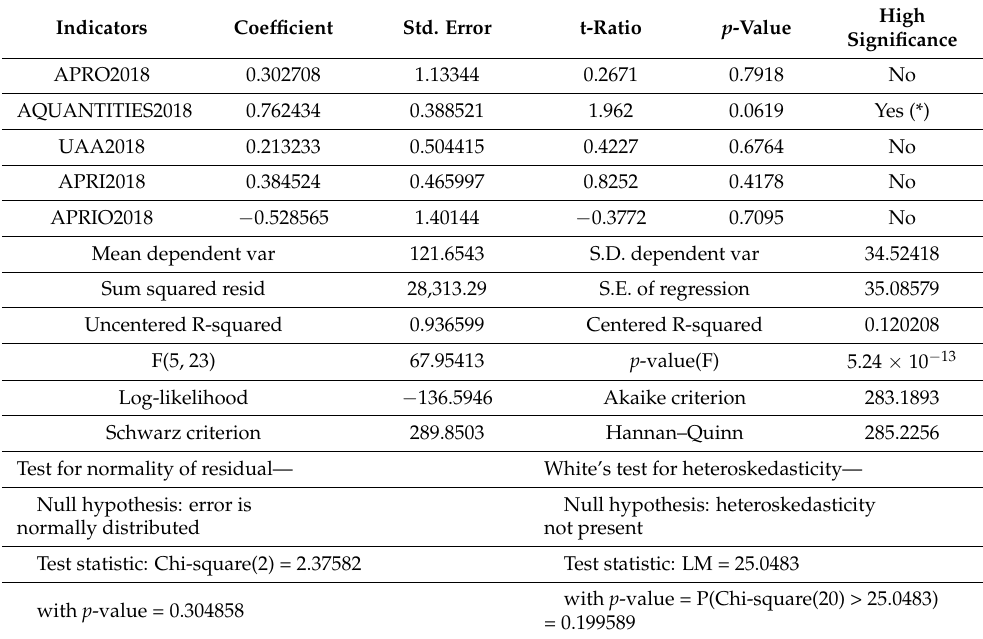
Table 8. Model 2018: OLS, using observations 1–28 (Dependent variable: